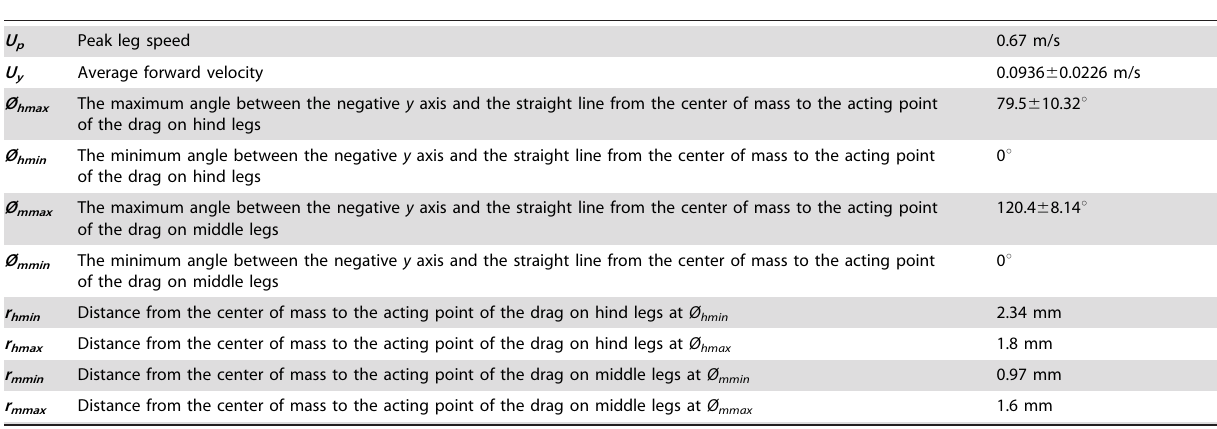
Table 2. Swimming parameters obtained from high-speed video